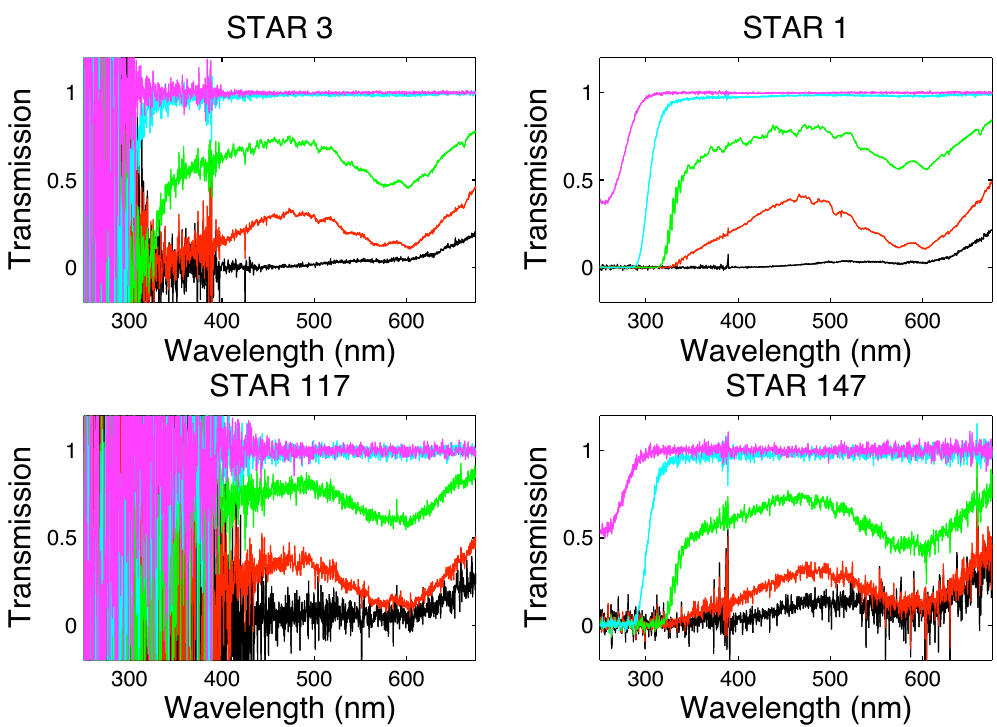
Fig. 2. Examples of GOMOS transmissions (corrected for refractive effects) measured using different stars. Top row on left: bright and cool star ( M v = − 0.05, T = 4300K) , on right: bright and hot star ( M v = − 1.44, T = 11000K). Bottom row, on left: dim and cool star ( M v =2.7, T = 3800K), on right: dim and hot star ( M v =2.88, T = 26000K). Five lines correspond to altitudes 10km (black), 20km (red), 30km (green), 50km (cyan) and 70km